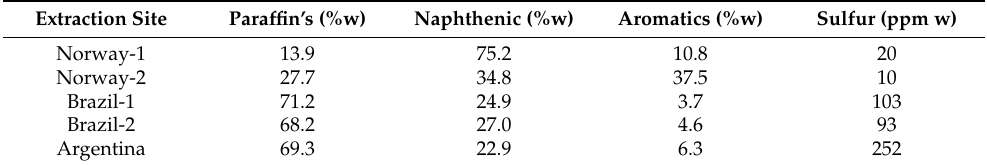
Table 1. Naphtha: average composition according to reservoir locality, adapted from References